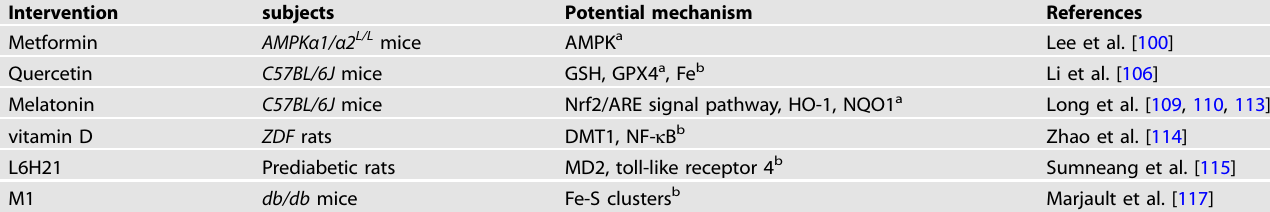
The level is higher than before the intervention. b The level is lower than before the